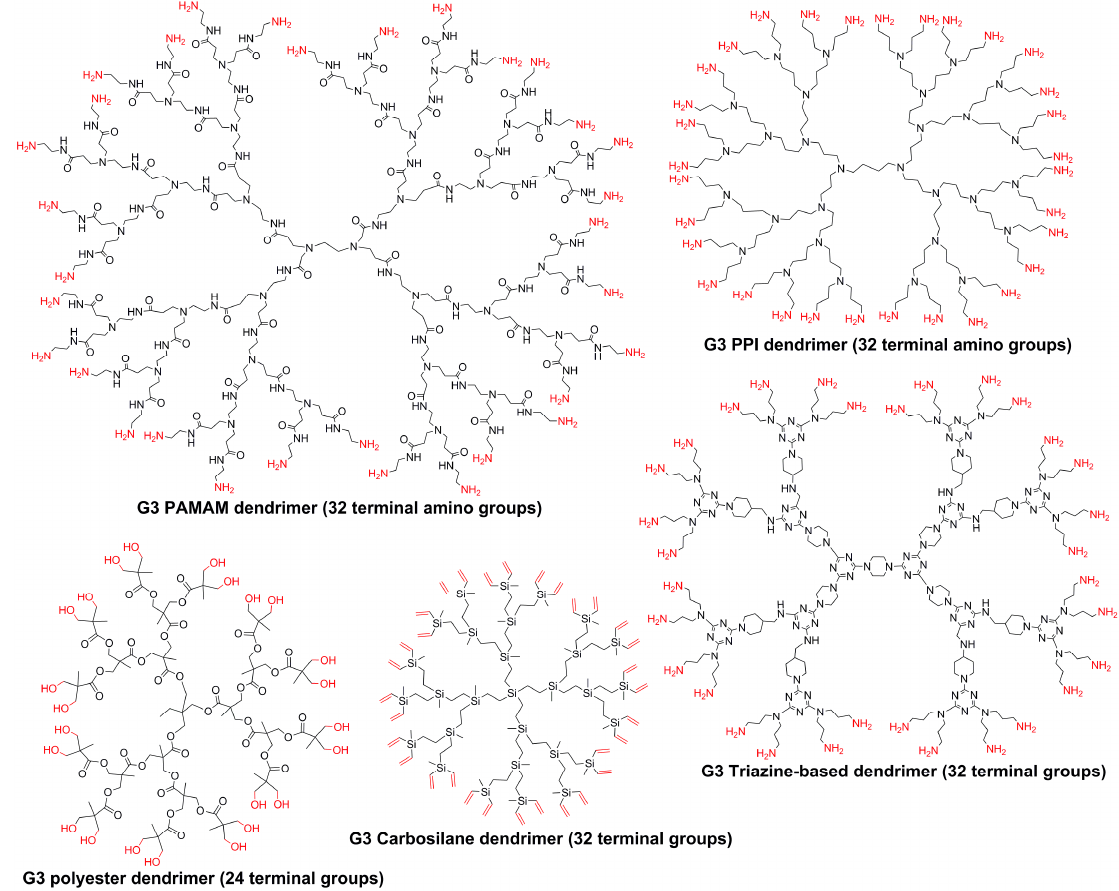
Figure 1. Chemical structure of different types of third-generation dendrimers.